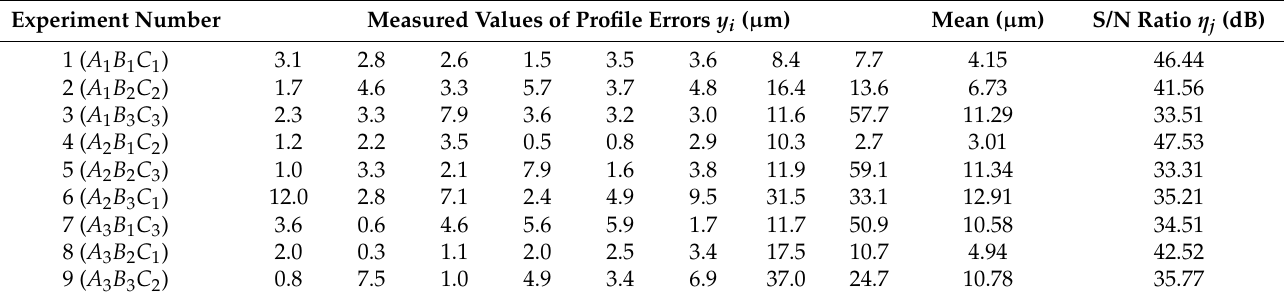
Table 10. Response table for S/N ratios for profile errors.